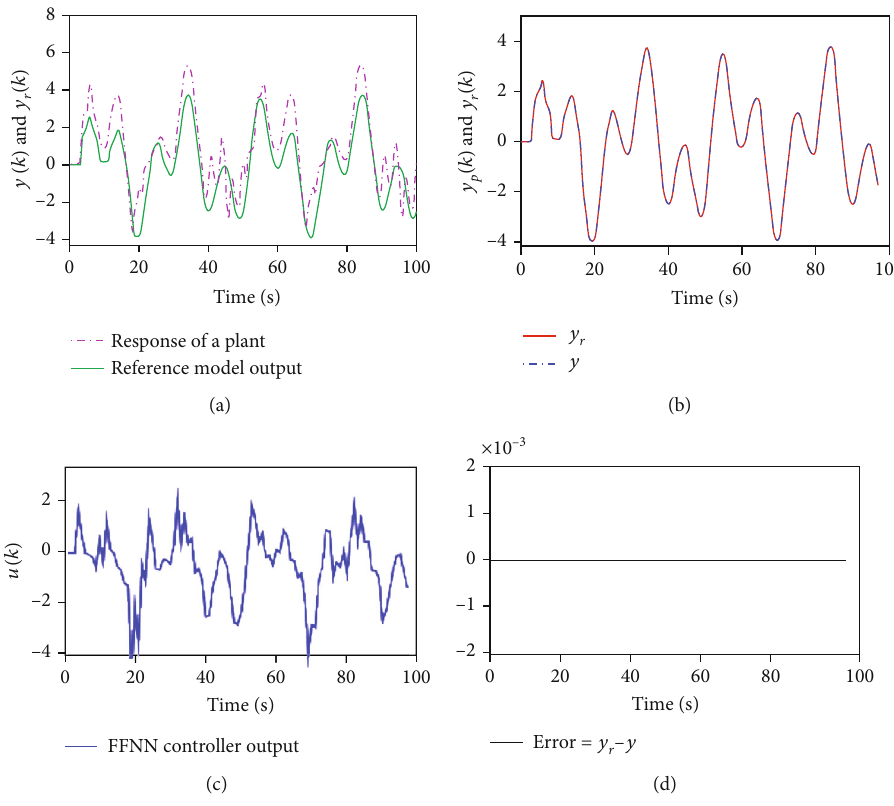
Figure 5: Example 1: (a) response for no control action (with r = u = sin ð 2 π k /25 Þ + sin ð 2 π k /10 Þ ), (b) outputs of the reference model and the plant with control action, (c) FFNN controller output, and (d) control